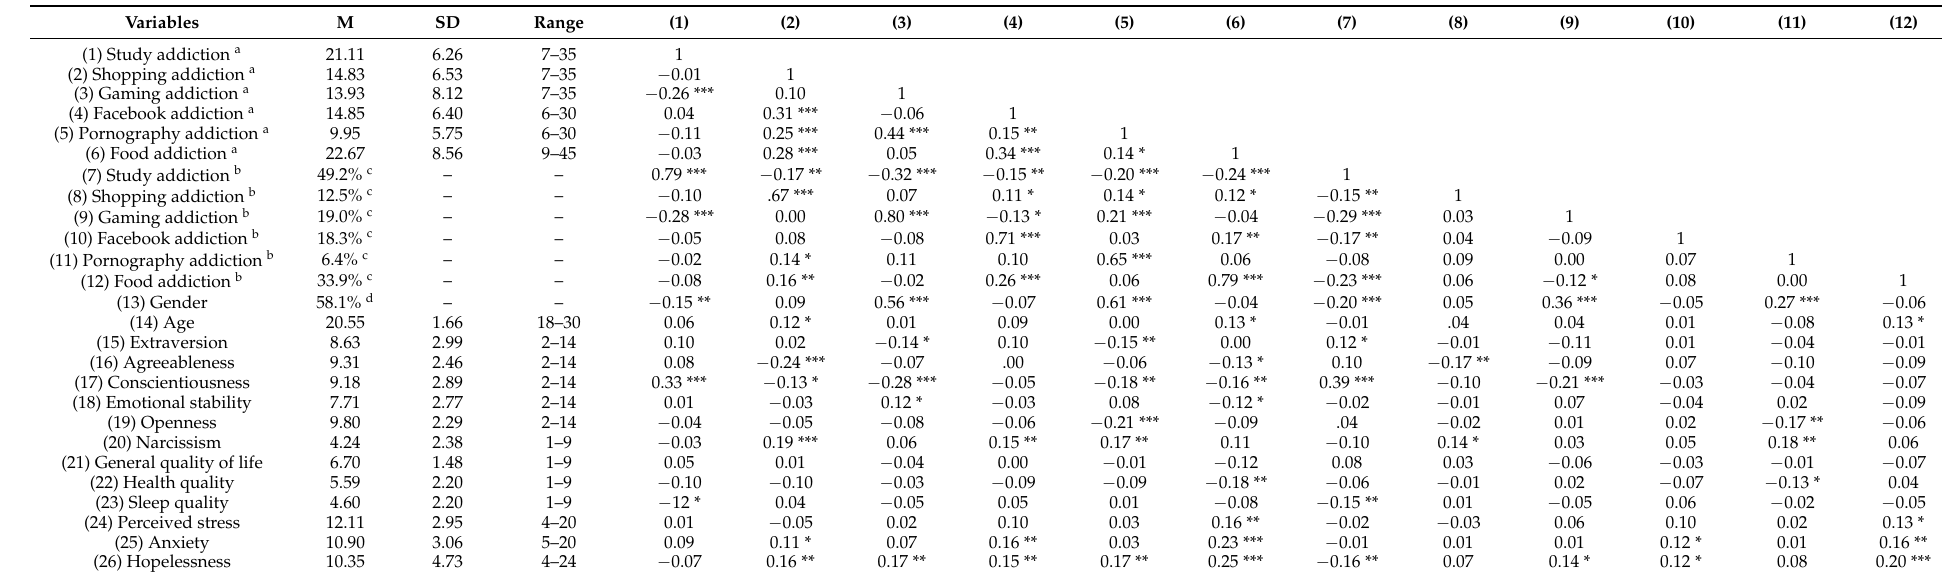
Table 4. Mean, Standard Deviations, and Correlations Between the Study